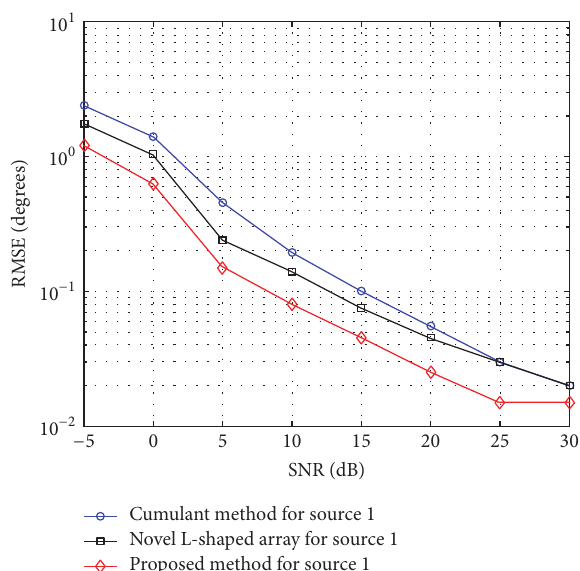
Figure 2: Comparison of RMSE of joint azimuth-elevation versus SNR for source 1 located at (75 ∘ , 60 ∘ ) using proposed method, novel L-shaped, and cumulant method.